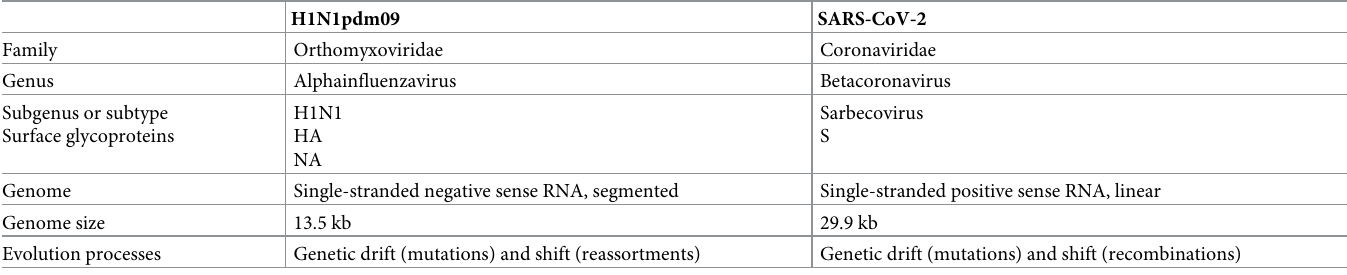
Table 1. Basic features of H1N1pdm09 and SARS-CoV-2